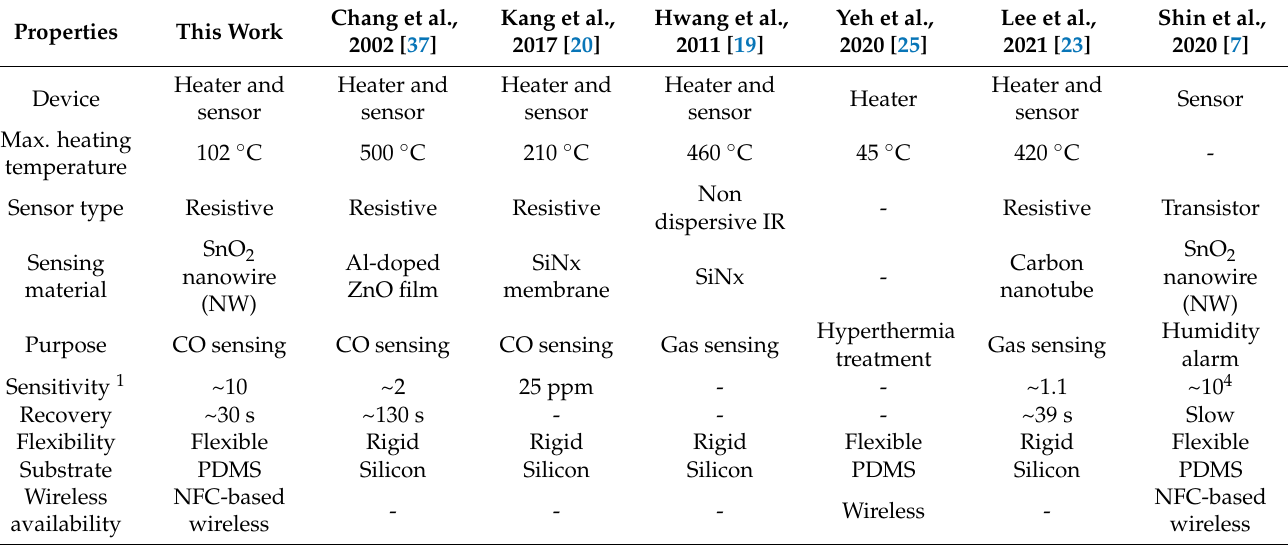
Table 1. Various reported devices consisting of gas sensors and